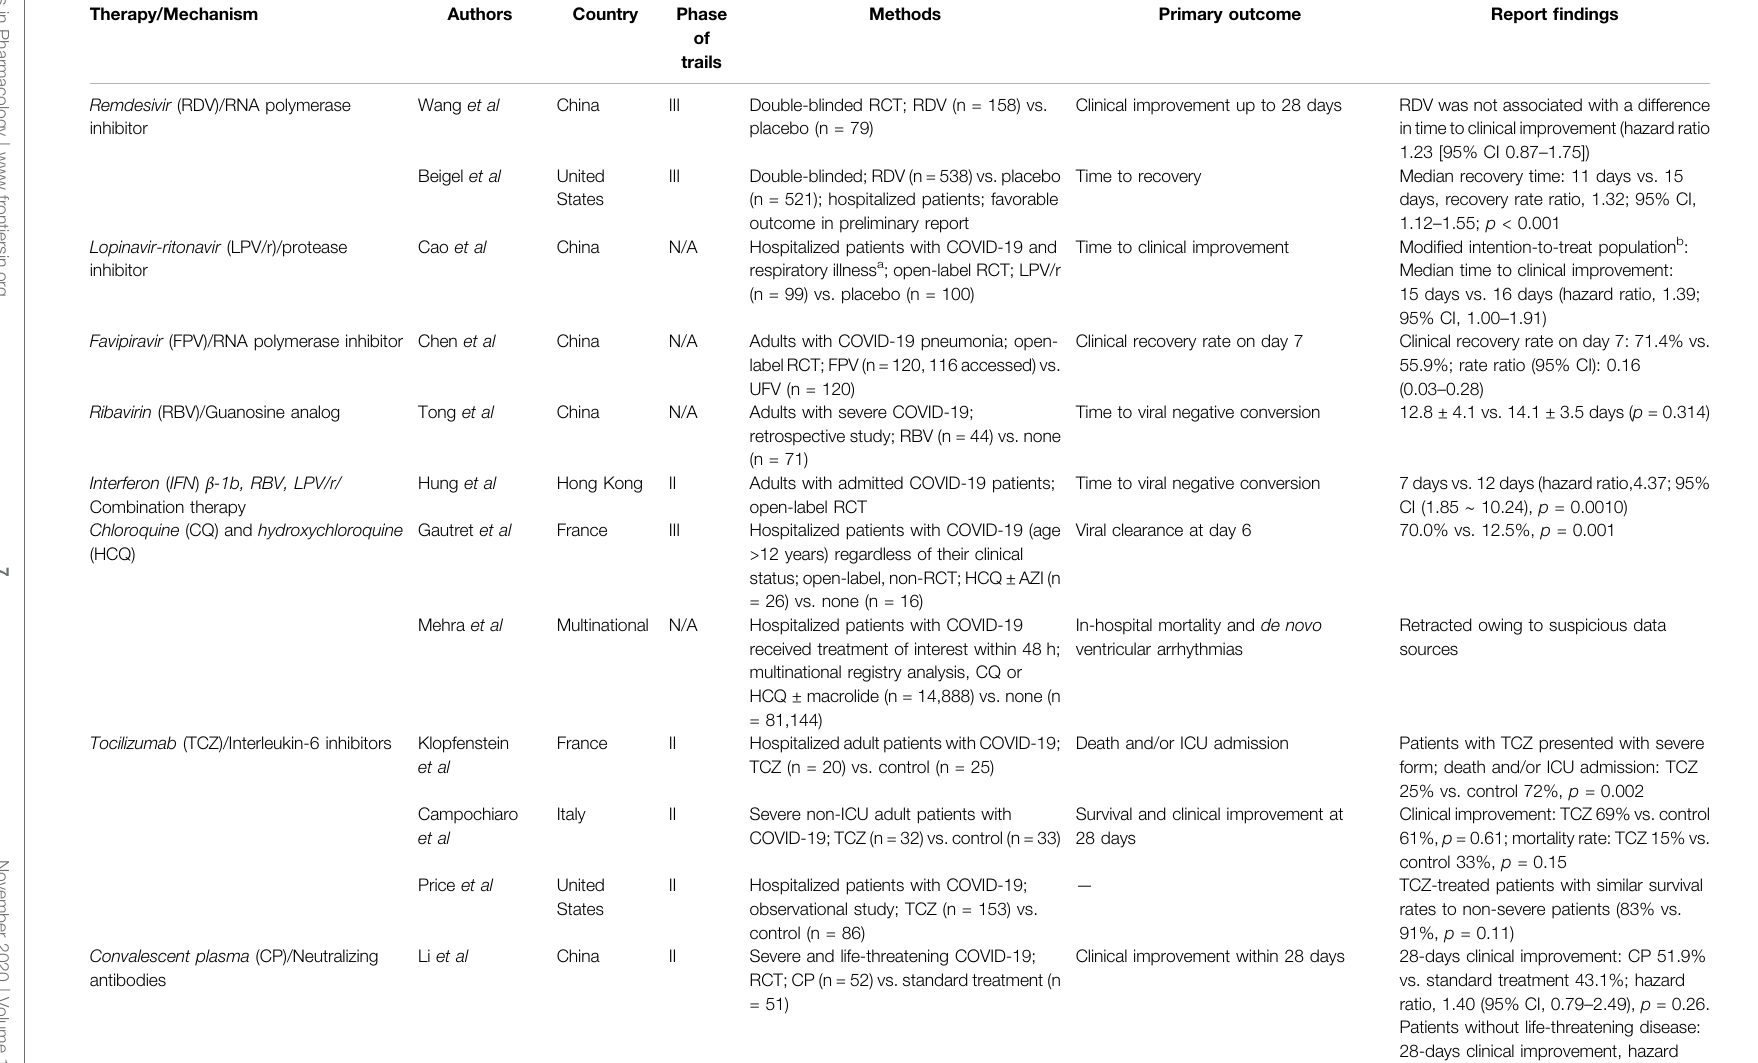
TABLE 2 | Repurposing of potential candidate drugs for